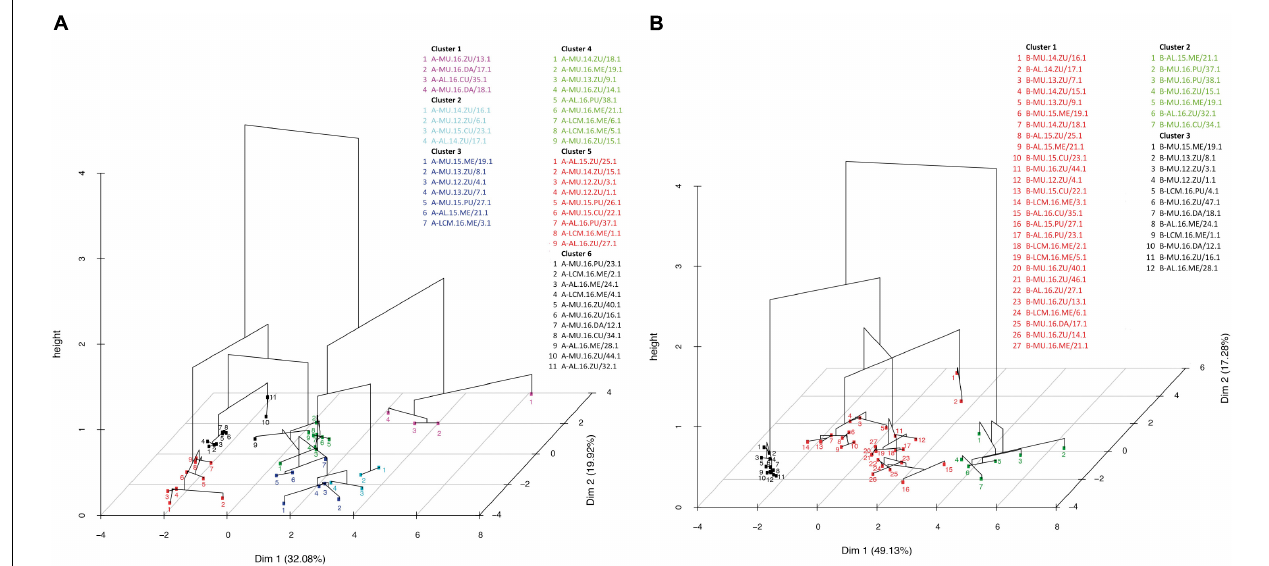
FIGURE 4 | Principal Component Analysis (PCAs) of both genomes for the ToLCNDV isolates. All isolates were clustered based on the correlation matrix of the genetic variables after normalization data. ToLCNDV isolates are colored according to the cluster, and each isolate is named after its location (MU, Murcia; AL, Alicante; CLM, Castilla-La Mancha), year (2012–2016), and host (ZU, Zucchini; ME, Melon; PU, Pumpkin; CU, Cucumber; DA, D. stramonium ). Supplementary Tables S3 and S4 show the significances and variable responsible for the group separation. In genome A (left), the six groups consisted of isolates that originated from the same year, whereas the three groups that originated in genome B (right) were fitted according to time and host.